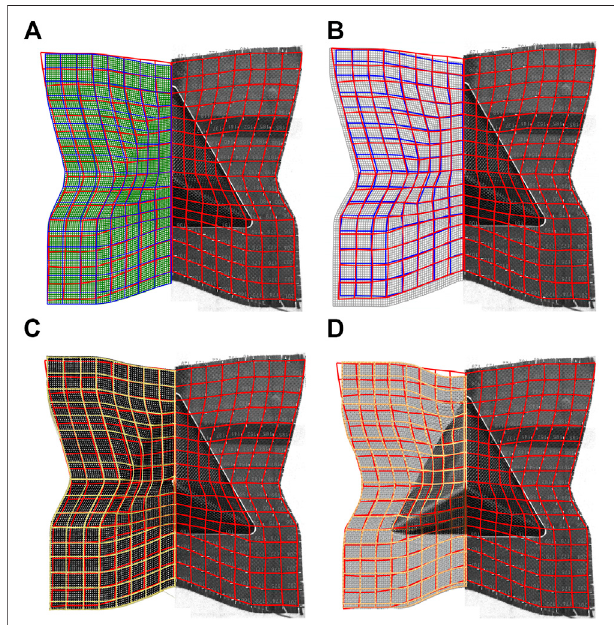
FIGURE 7 | Comparison of the predicted formed fabric pro fi les with experiment resutls in (A) the FEA-PJN model (pro fi le marked with blue lines), (B) the HypoDrape model (pro fi le marked with blue lines), (C) the MF model (isolated yarns coloured in yellow), and (D) the 3DShell model (isolated yarns coloured in white) for tetrehedron forming. Deformed pro fi le of the specimen (only half of which is shown) indicated by red lines at the RHS is overlaid to the deformed pro fi le of fabric model shown at the